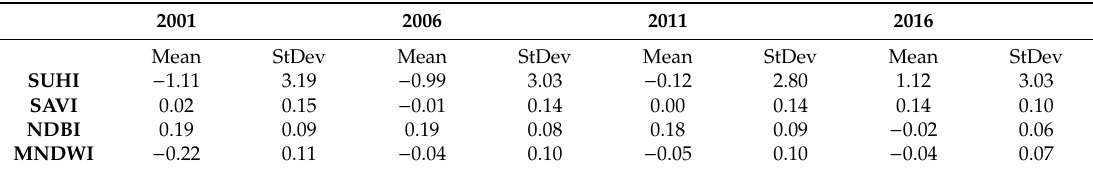
Table 1. Descriptive statistics of the surface urban heat island (SUHI) intensity and biophysical variables for years 2001, 2006, 2011, and